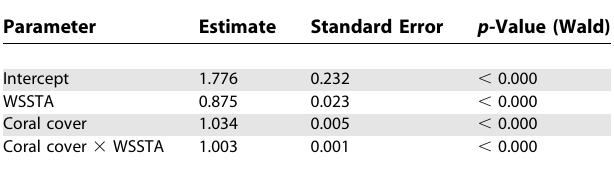
Table 1. Observed Number of White Syndrome Cases WSSTA